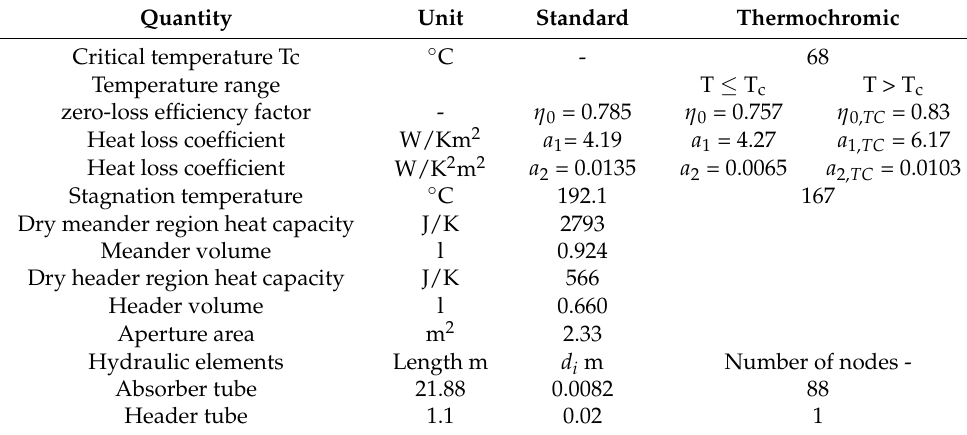
Table A1. Model characteristics of